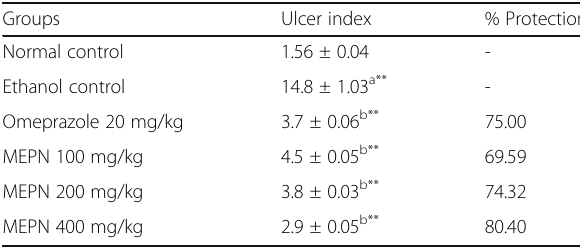
Table 3 Effect of P. niruri leaves extract on various parameters in ethanol induced gastric ulcer